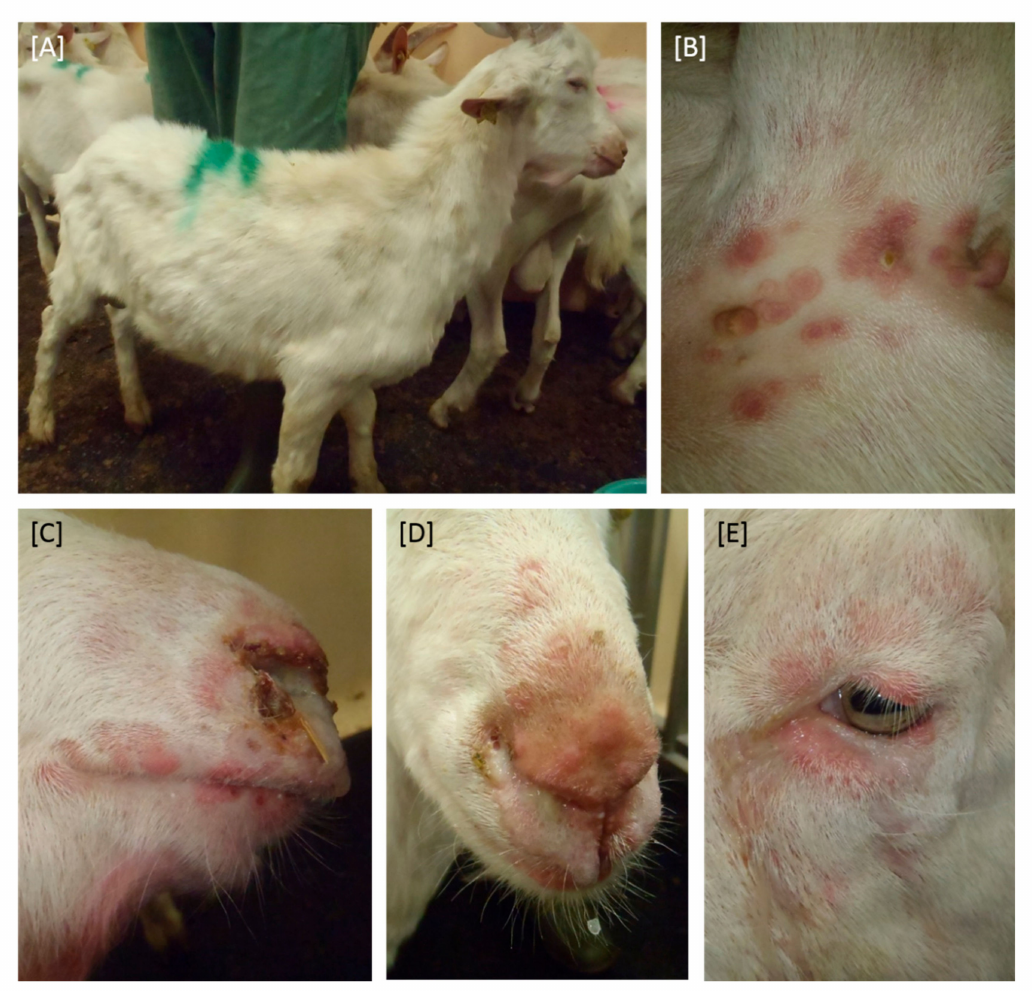
Figure 1. Clinical signs after inoculation with GTPV-“V / 103“. All goats, independent whether inoculated intravenously and subcutaneously or intranasally as well as in-contact animals developed clinical symptoms characteristic for goat pox like lesions of the skin ( A – E ), nasal ( C , D ), and ocular discharge ( E